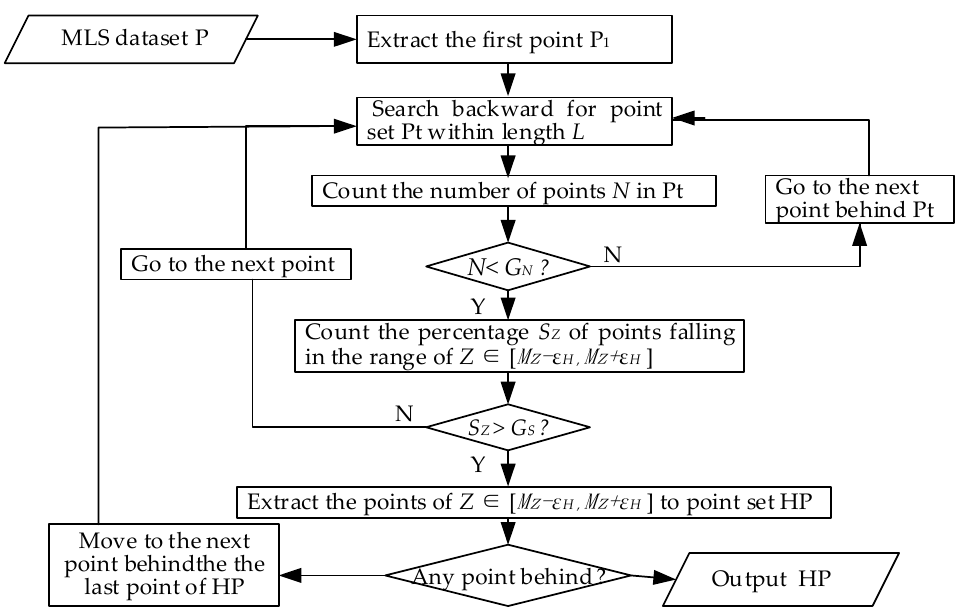
Figure 2. The process of extraction of rough road point.